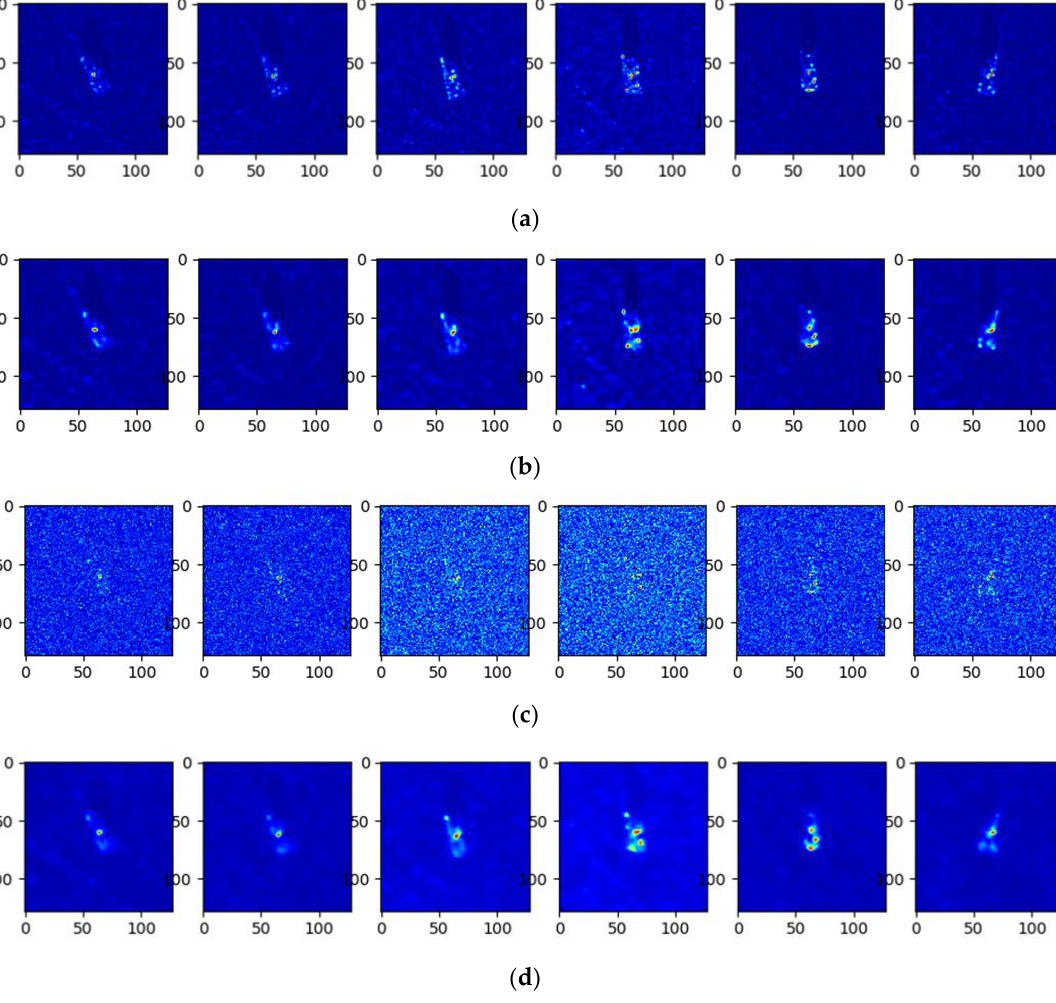
Figure 14. The input images and reconstruction results of the trained model at the noise levels of 10 dB SNR and −10 dB SNR. ( a ) Input images at a noise level of 10 dB SNR, ( b ) the reconstructed results of ( a ), ( c ) the input images at a noise level of -10dB SNR, ( d ) the reconstructed results of ( c ).